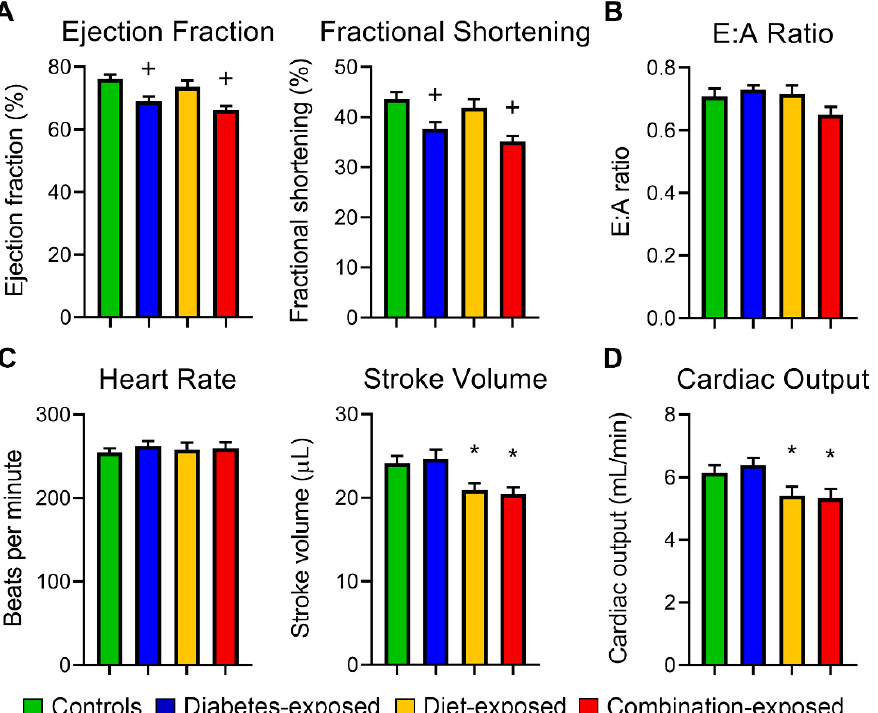
Figure 1. Diabetes- and high-fat (HF) diet-exposed newborn males had significant cardiac dysfunction at birth. ( A ) Systolic function, ( B ) diastolic function, ( C ) heart rate and stroke volume were determined in P1 offspring by echocardiography. ( D ) Cardiac output was calculated from ( C ). N = 12–19 offspring/group. Significant differences ( p ≤ 0.05): + diabetes or *diet effect by 2-way NOVA.